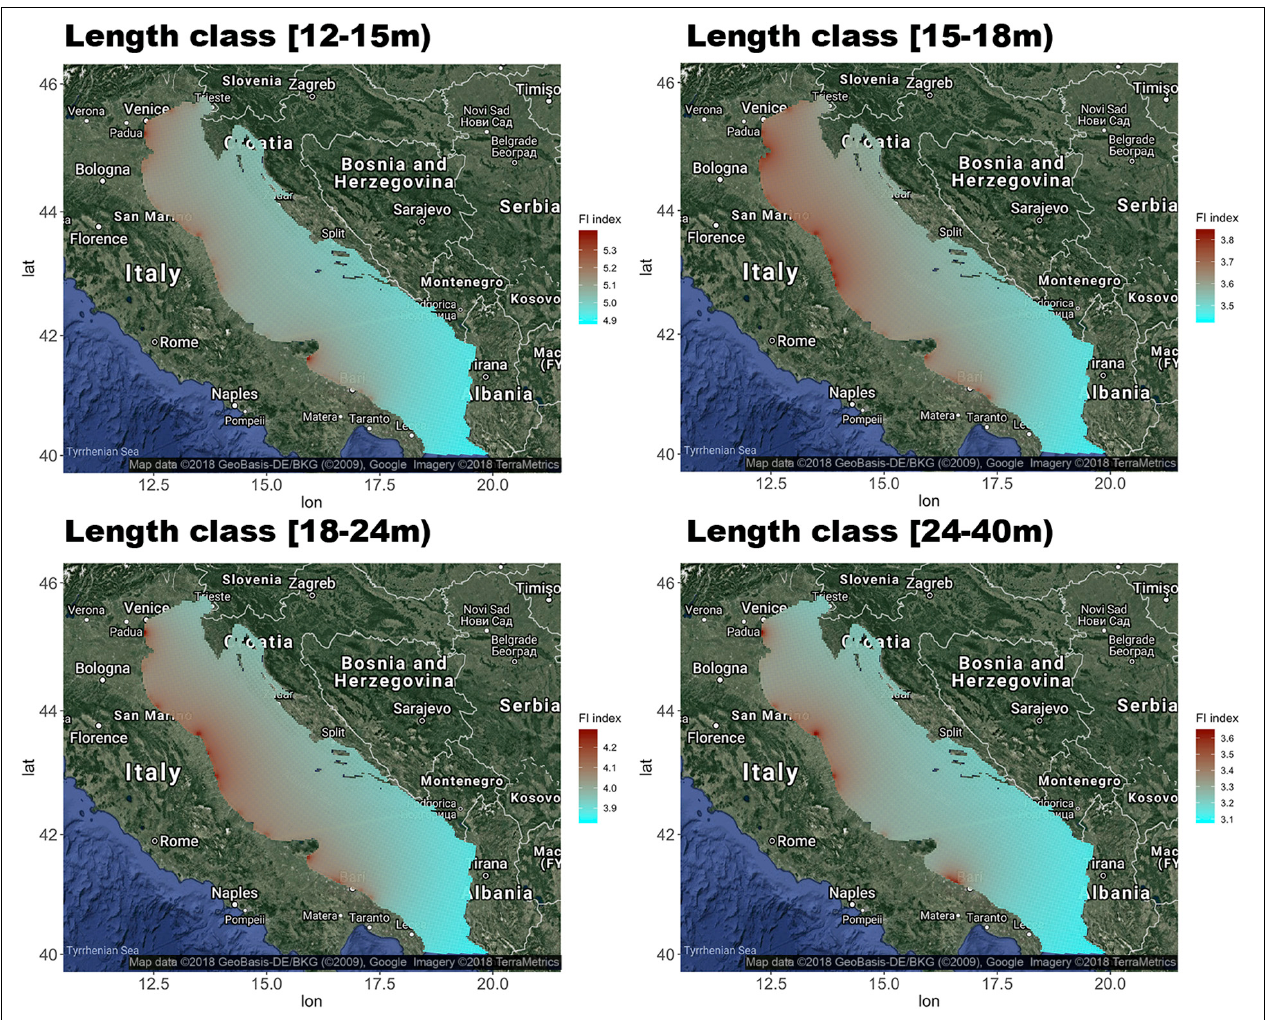
FIGURE 5 | Spatial patterns of the FI index, by length class, computed considering the official (i.e., total) number of Italian trawlers by harbor/length class ( Table 2 ). The FI index is defined as a function of the size of the fleet segment (i.e., the number of trawlers) and the distance from the center of each cell to the harbor. The figures were created using the R package ggmap (Kahle and Wickham, 2013) importing images from Google